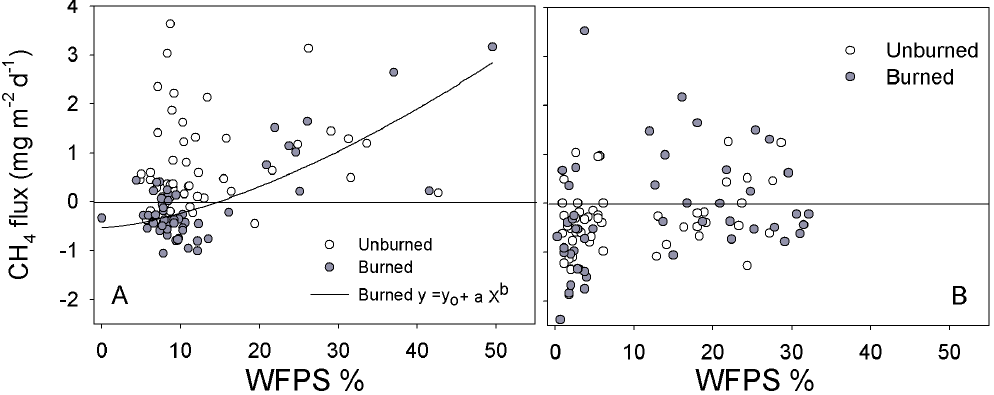
Fig. 5. Single chamber CH 4 fluxes (mgCH 4 m − 2 d − 1 ) plotted versus soil water filled pore space (%) reported for the 1st campaign (A) one month after burning and the 2nd campaign (B) eight months after burning. In graph A line represents the fit of data from burned plots (y 0 = −